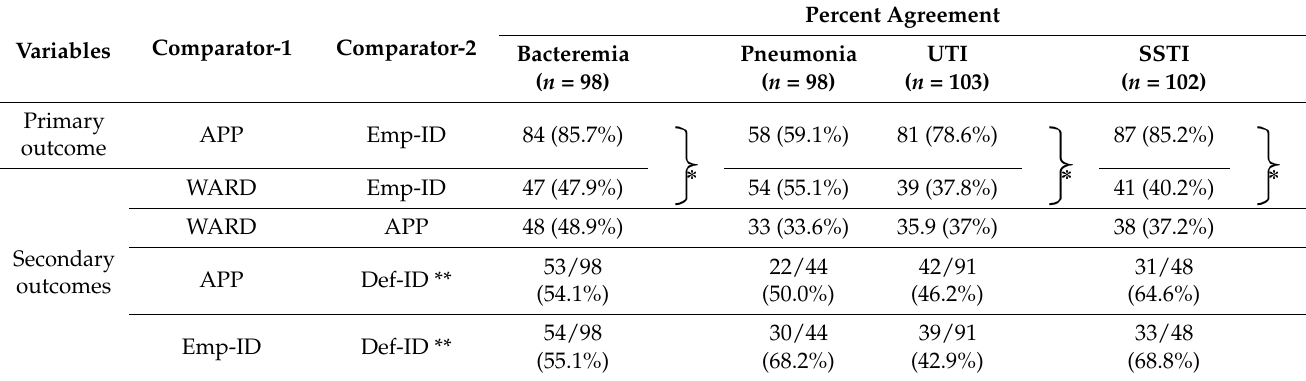
Table 2. Percent agreement of each comparison group, stratified by the infection site.